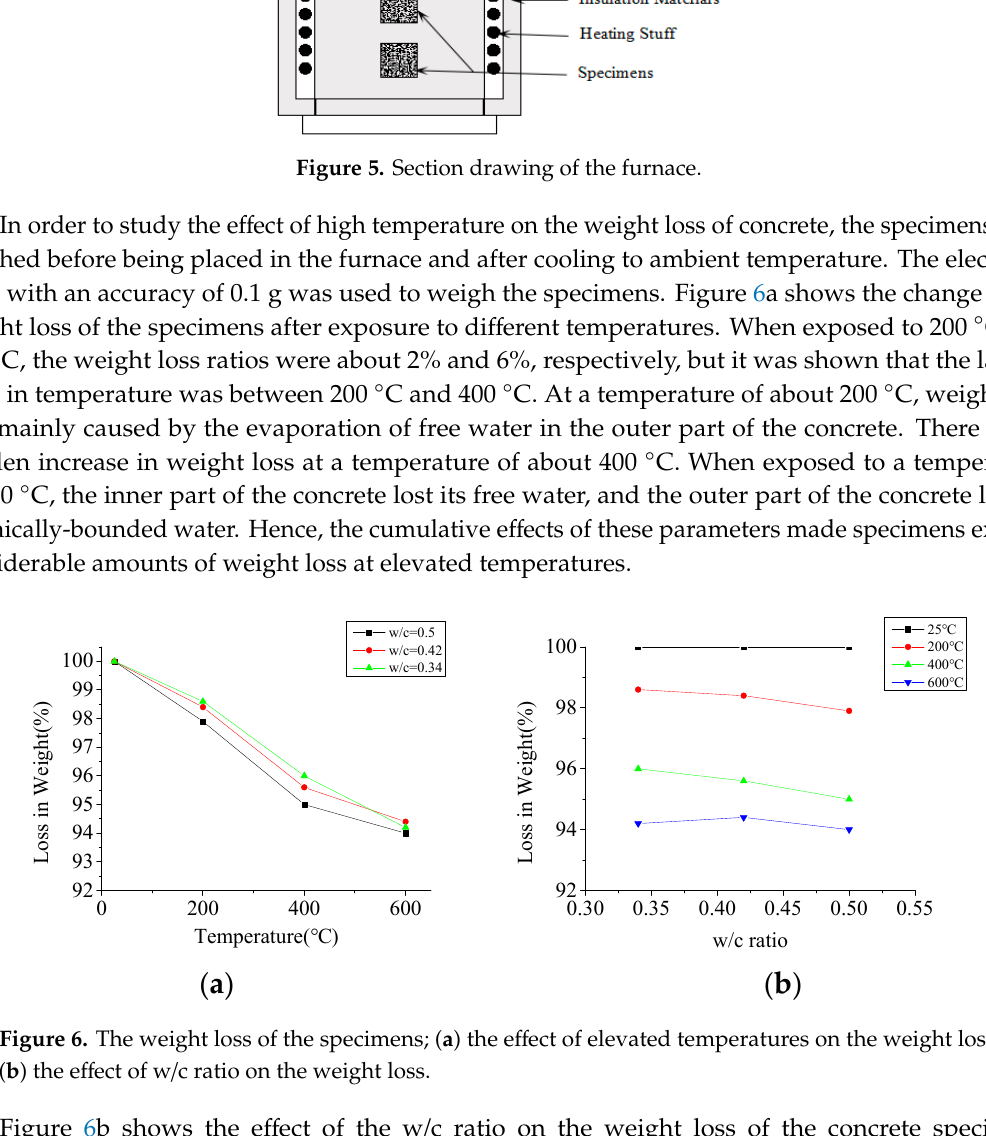
Figure 5. Section drawing of the furnace.